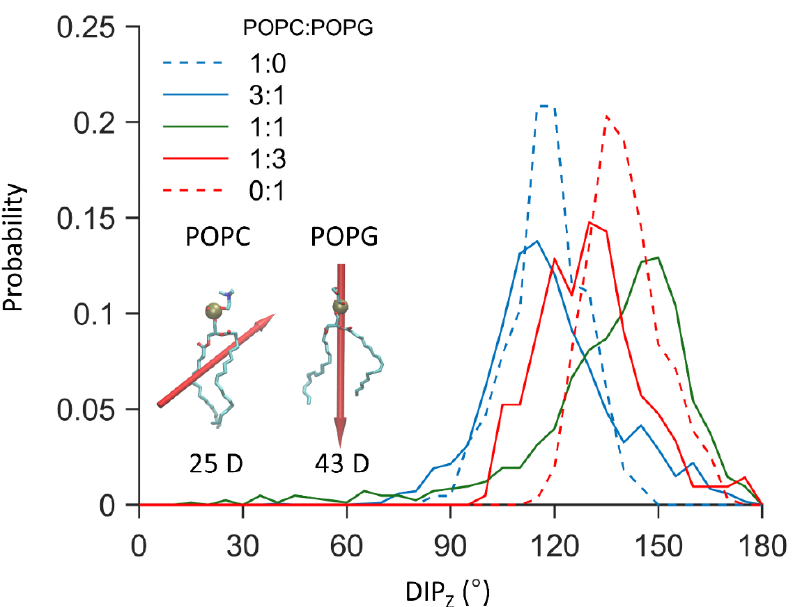
Figure 5. Probability distribution of the dipole angle with respect to the positive z-axis of membrane inserted SNX-482. Insert shows a licorice representation of POPC and POPG molecules with their respective dipole shown as red arrows, arrow size is proportional to the dipole magnitude of the phospholipid. The data was obtained from the unrestrained AT simulation showing spontaneous binding.